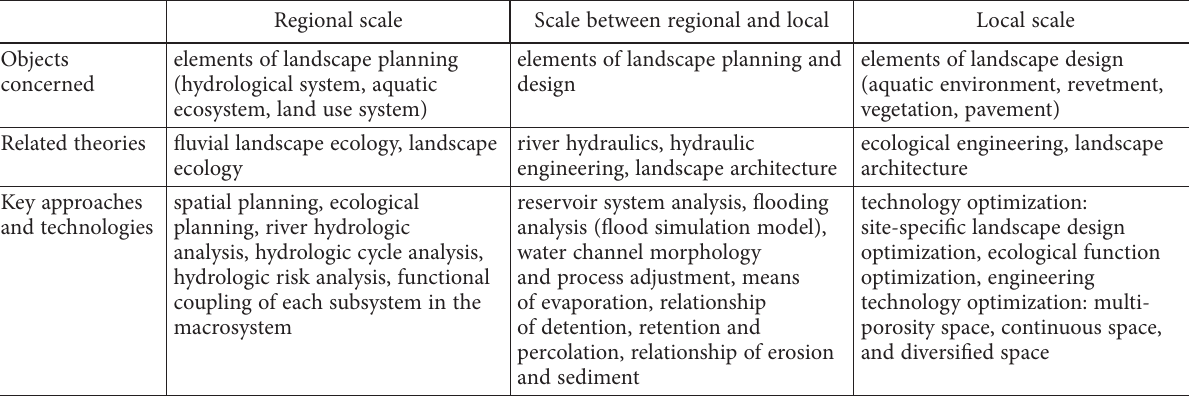
Table 3. Characteristics of flood resilience to landscape architecture on different scales Regional scale Scale between regional and local Local